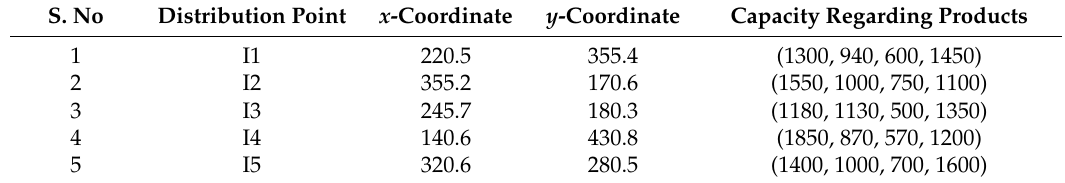
Table 6. Information of distribution points.